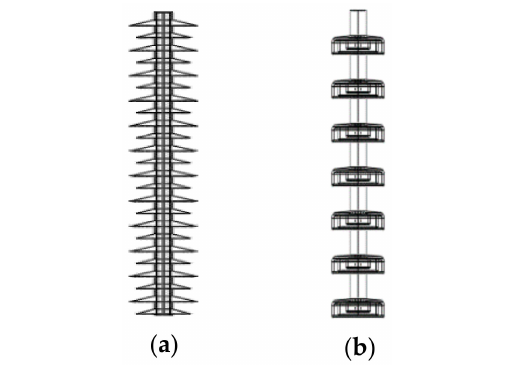
Figure 5. The simplified geometry of the insulators. ( a ) Composite insulator; ( b ) Glass